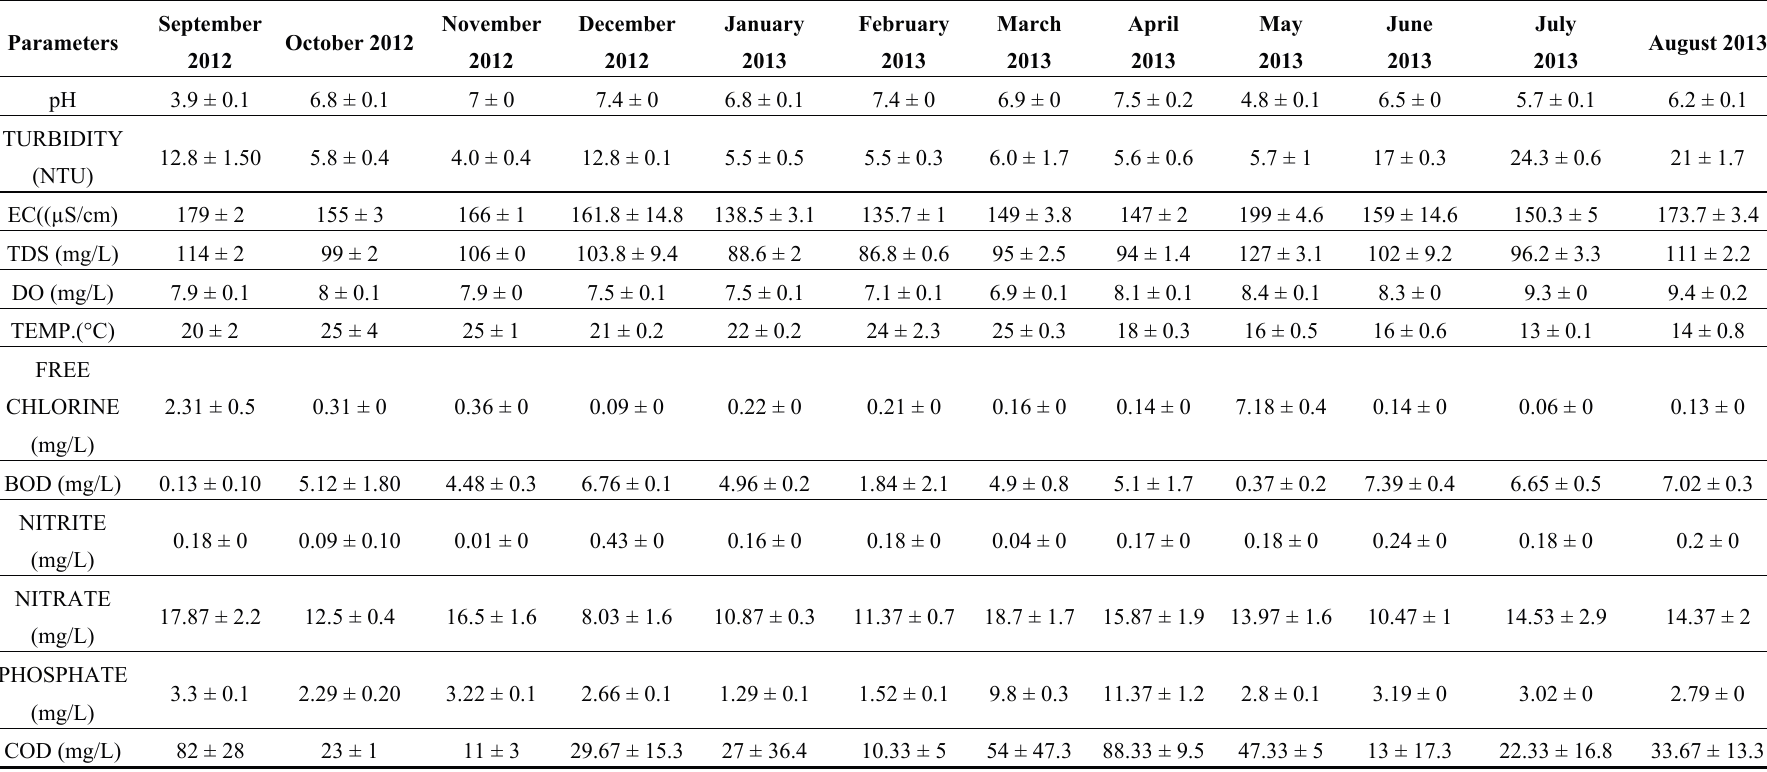
Table 3. The average means of the measured physiochemical parameters for the